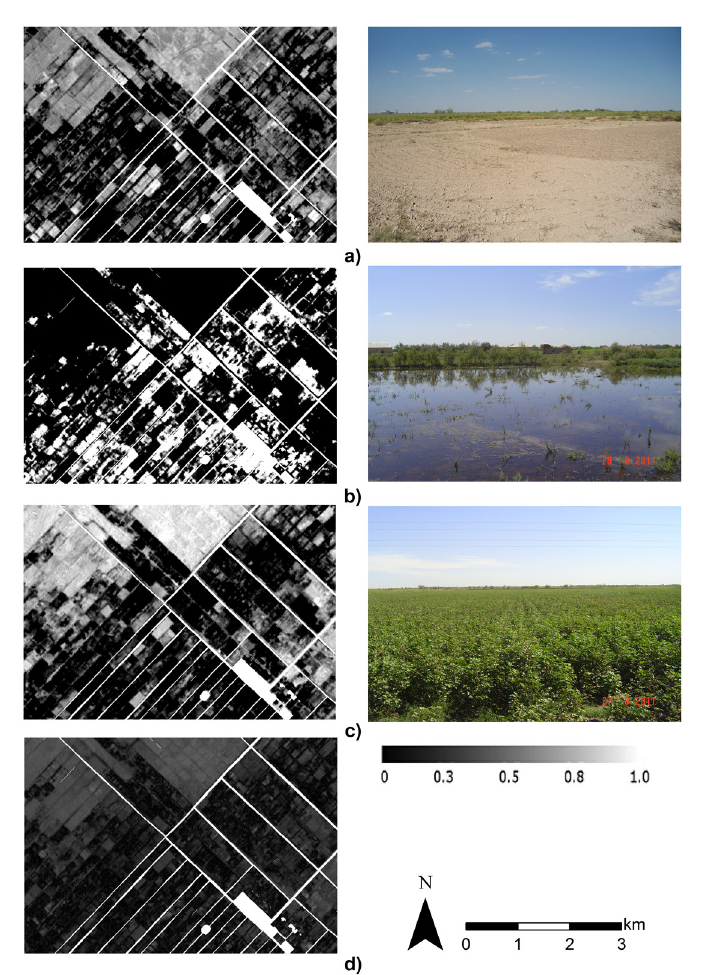
Figure 3. Subsets of fraction images derived from linear unmixing of the August 2010 SPOT-5 image and their corresponding land cover elements: ( a ) bare soil, ( b ) water surfaces, ( c ) photosynthetically active vegetation, ( d ) root mean square